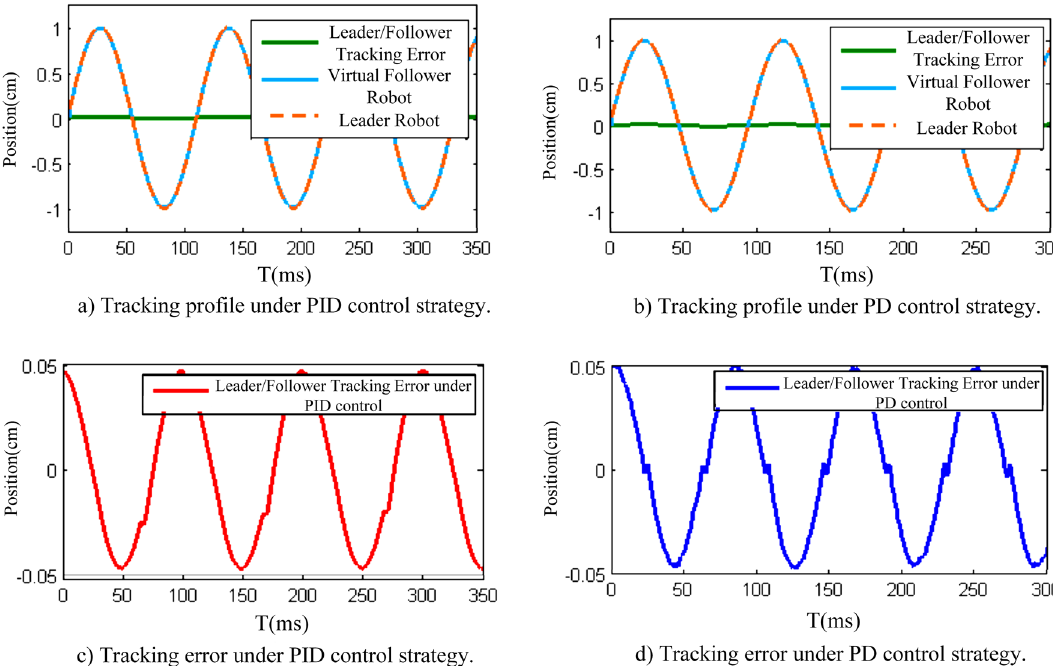
Figure 14. Leader–follower position tracking error profiles under different control